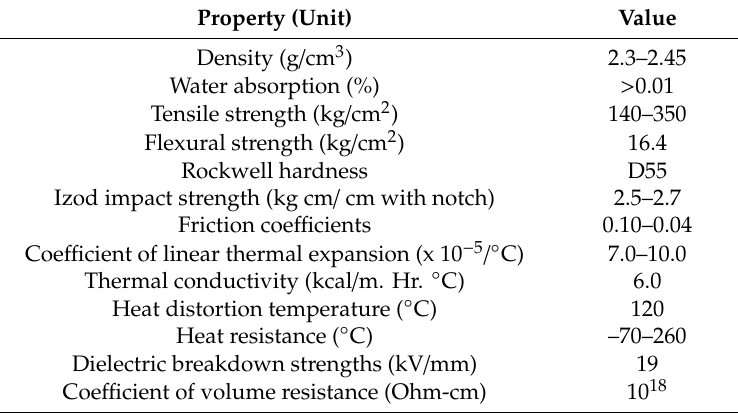
Table 2. Physical properties of the polytetrafluoroethylene (PTFE)